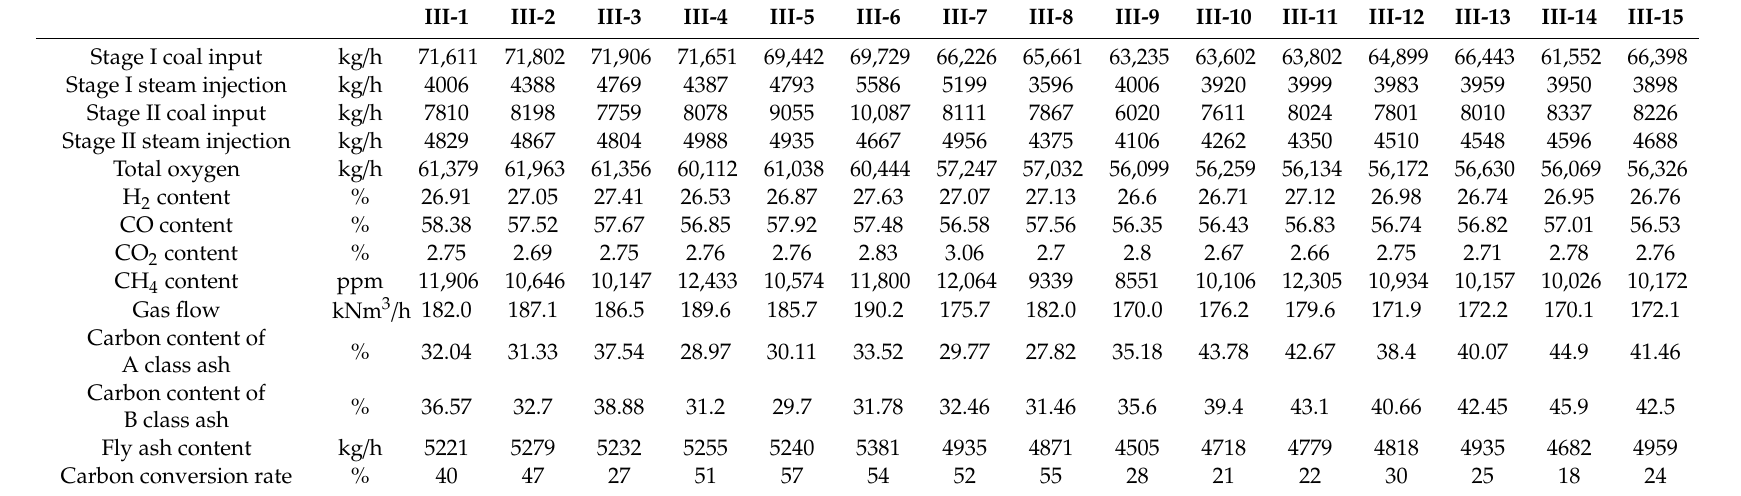
Table 8. Long period test